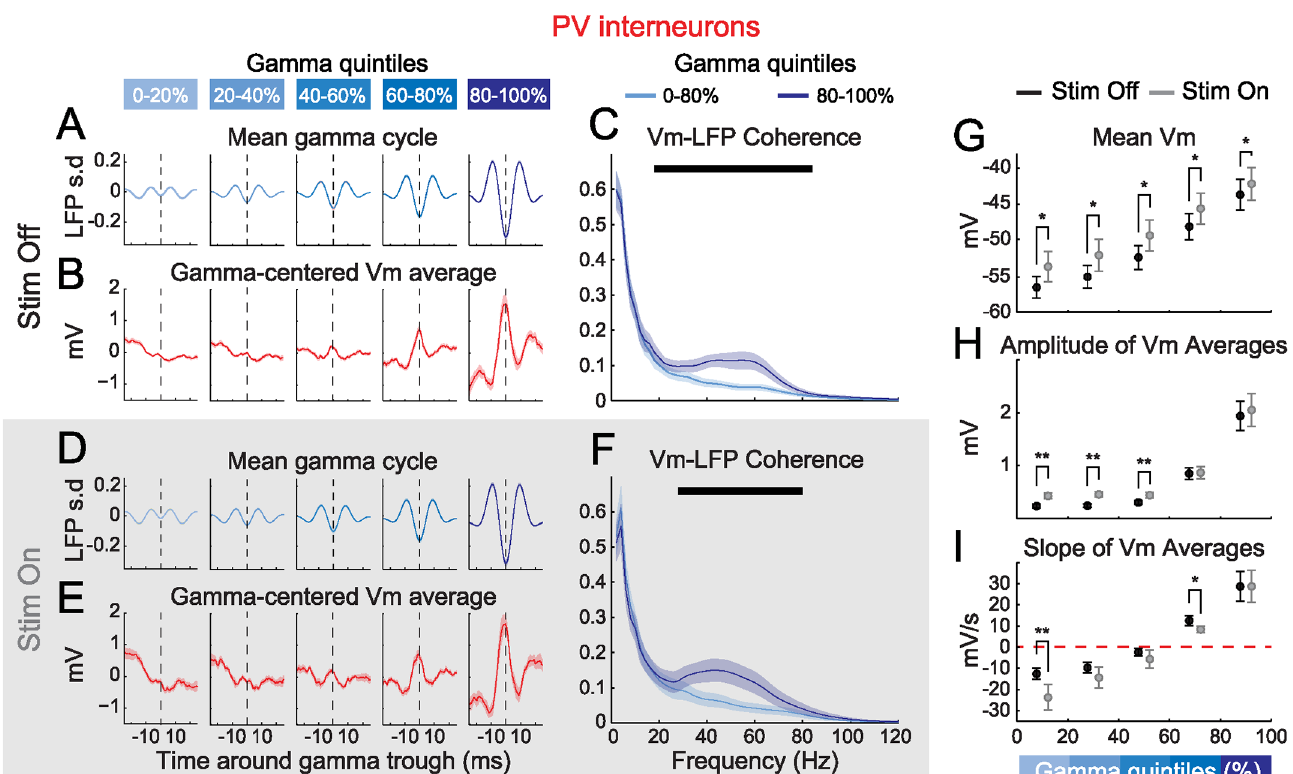
Fig 4. Strong gamma oscillations entrain Vm in PVs and occur when PVs depolarize. ( A, D ) Grand mean of trough-centered segments of the gamma- filtered LFP, outside (A) and during (D) visual stimulation, as a function of gamma quintile at trough time ( n = 10; shaded areas: +/- s.e.m.). ( B, E ) Grand mean of simultaneously recorded PV Vm segments ( n = 10; shaded areas: +/- s.e.m.). ( C, F ) Strong gamma oscillations increase PV Vm-LFP coherence in the gamma range (30 – 80 Hz) outside (C) and during (F) visual stimulation ( n = 10; light and dark blue traces: grand mean coherence respectively in the four weakest quintiles and in the strongest gamma quintile; shaded areas: +/- s.e.m; black horizontal line: statistical significance between the four weakest quintiles and the strongest gamma quintile, FDR corrected signed-rank test, α = 0.05). ( G ) Grand mean DC Vm of PVs as a function of gamma quintile outside (Stim Off, black) and during (Stim On, grey) visual stimulation ( n = 10; error bars: s.e.m.; * : p < 0.05, signed rank test). ( H ) Grand mean amplitude of gamma-centered Vm averages outside (Stim Off, black) and during (Stim On, grey) visual stimulation ( n = 10; error bars: s.e.m.; ** : p < 0.01, signed rank test). ( I ) Grand mean slope of linear fits to gamma-centered Vm averages outside (Stim Off, black) and during (Stim On, grey) visual stimulation ( n = 10; error bars: s.e.m.; * : p < 0.05, ** : p < 0.01, signed-rank test).